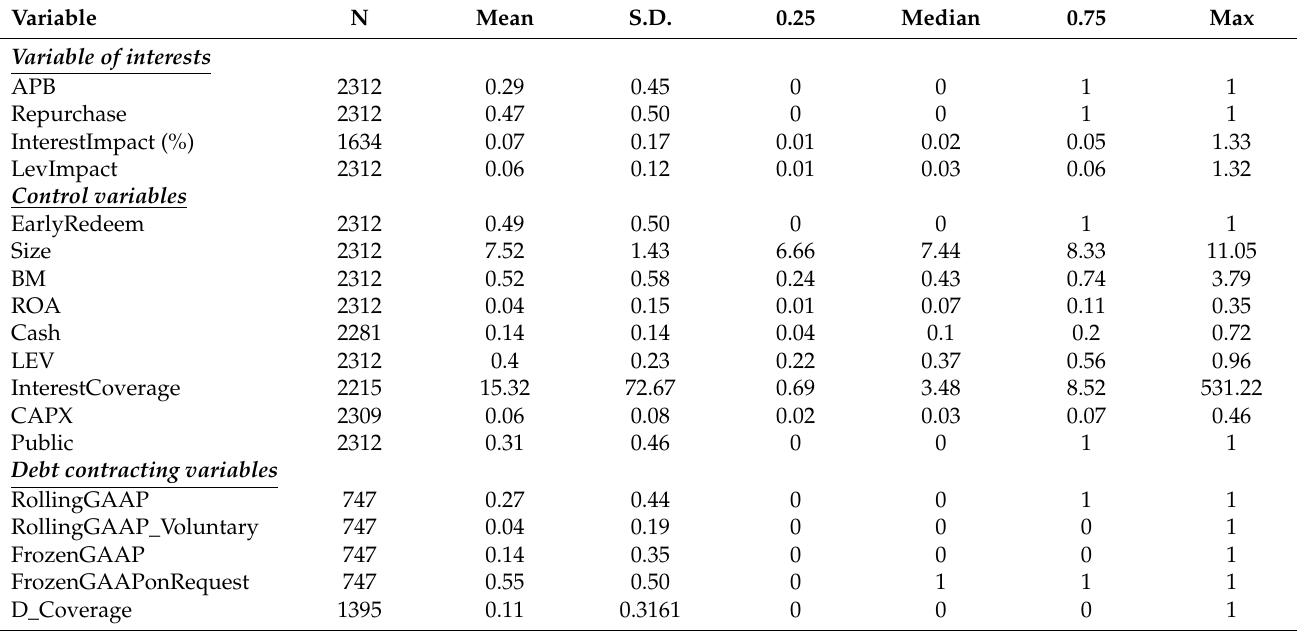
Table 3. Descriptive statistics.